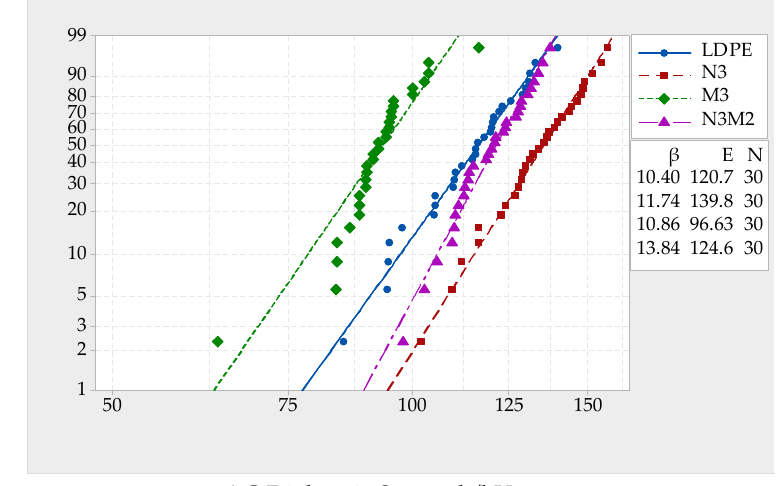
Figure 6. Weibull distribution curve of the samples in the AC field.